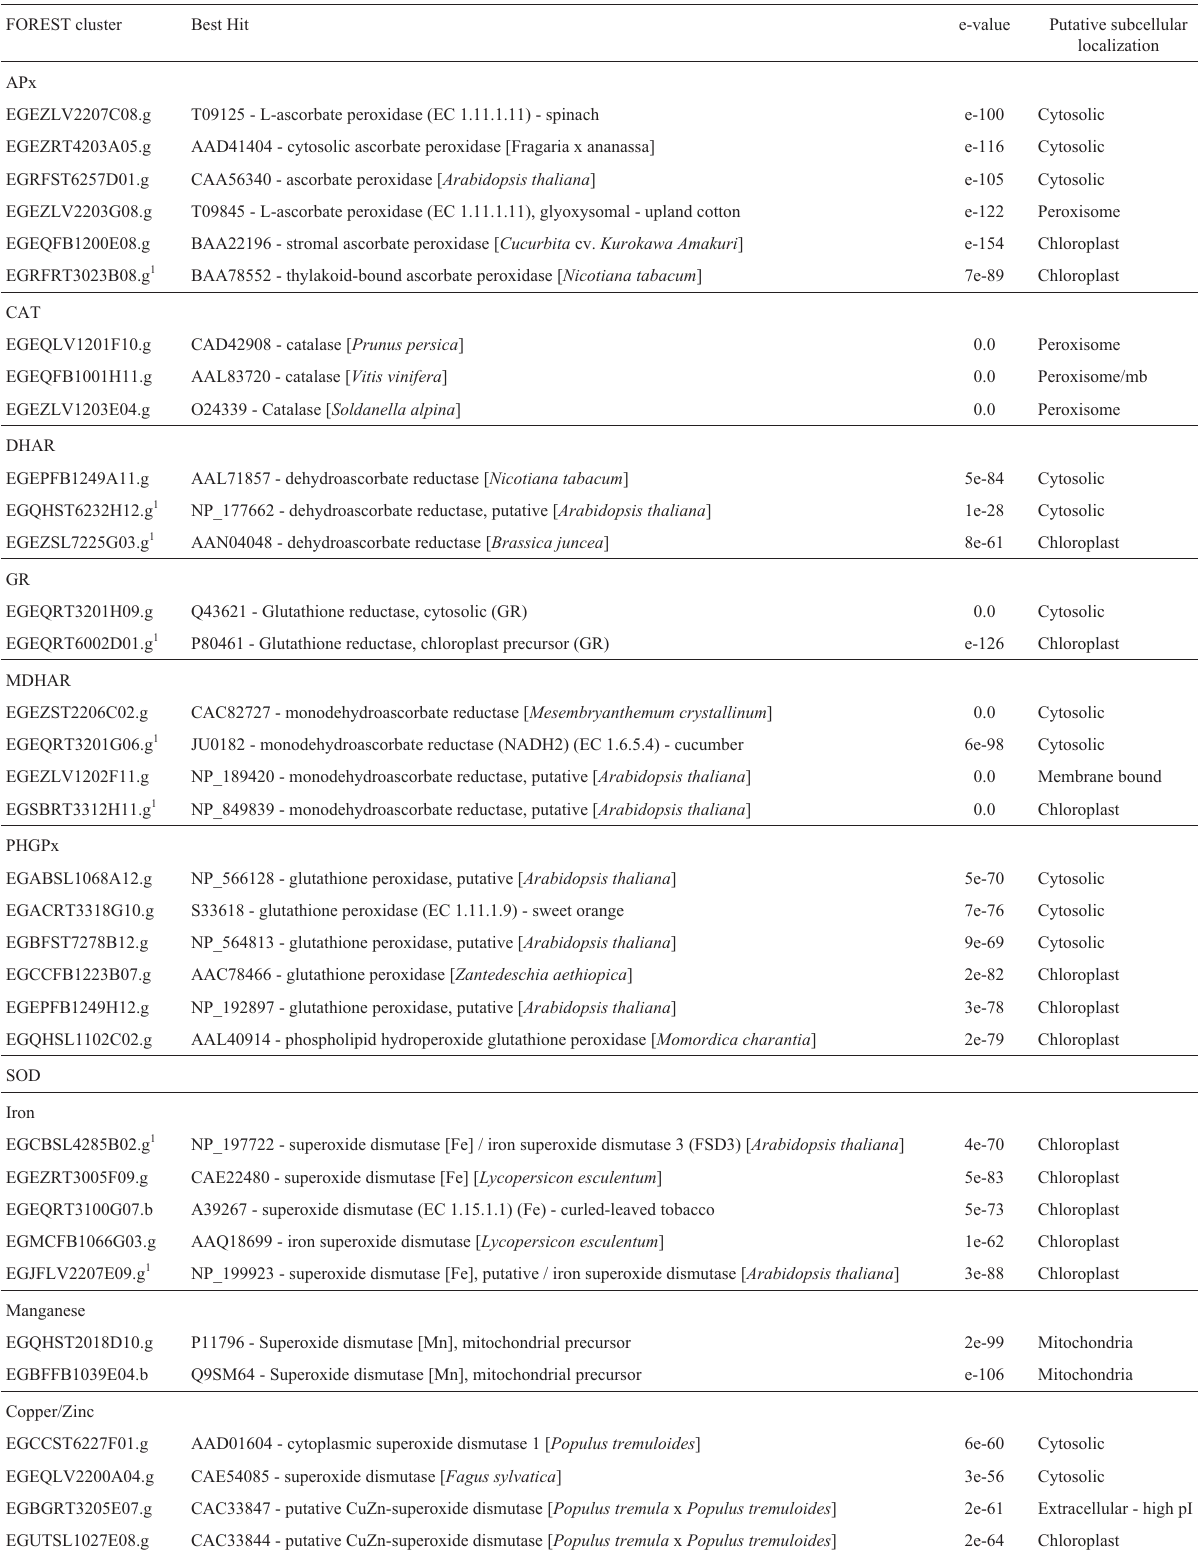
Table 1 - Antioxidant enzyme encoding clusters in the FORESTs databank ( 1 Incomplete clusters). FOREST